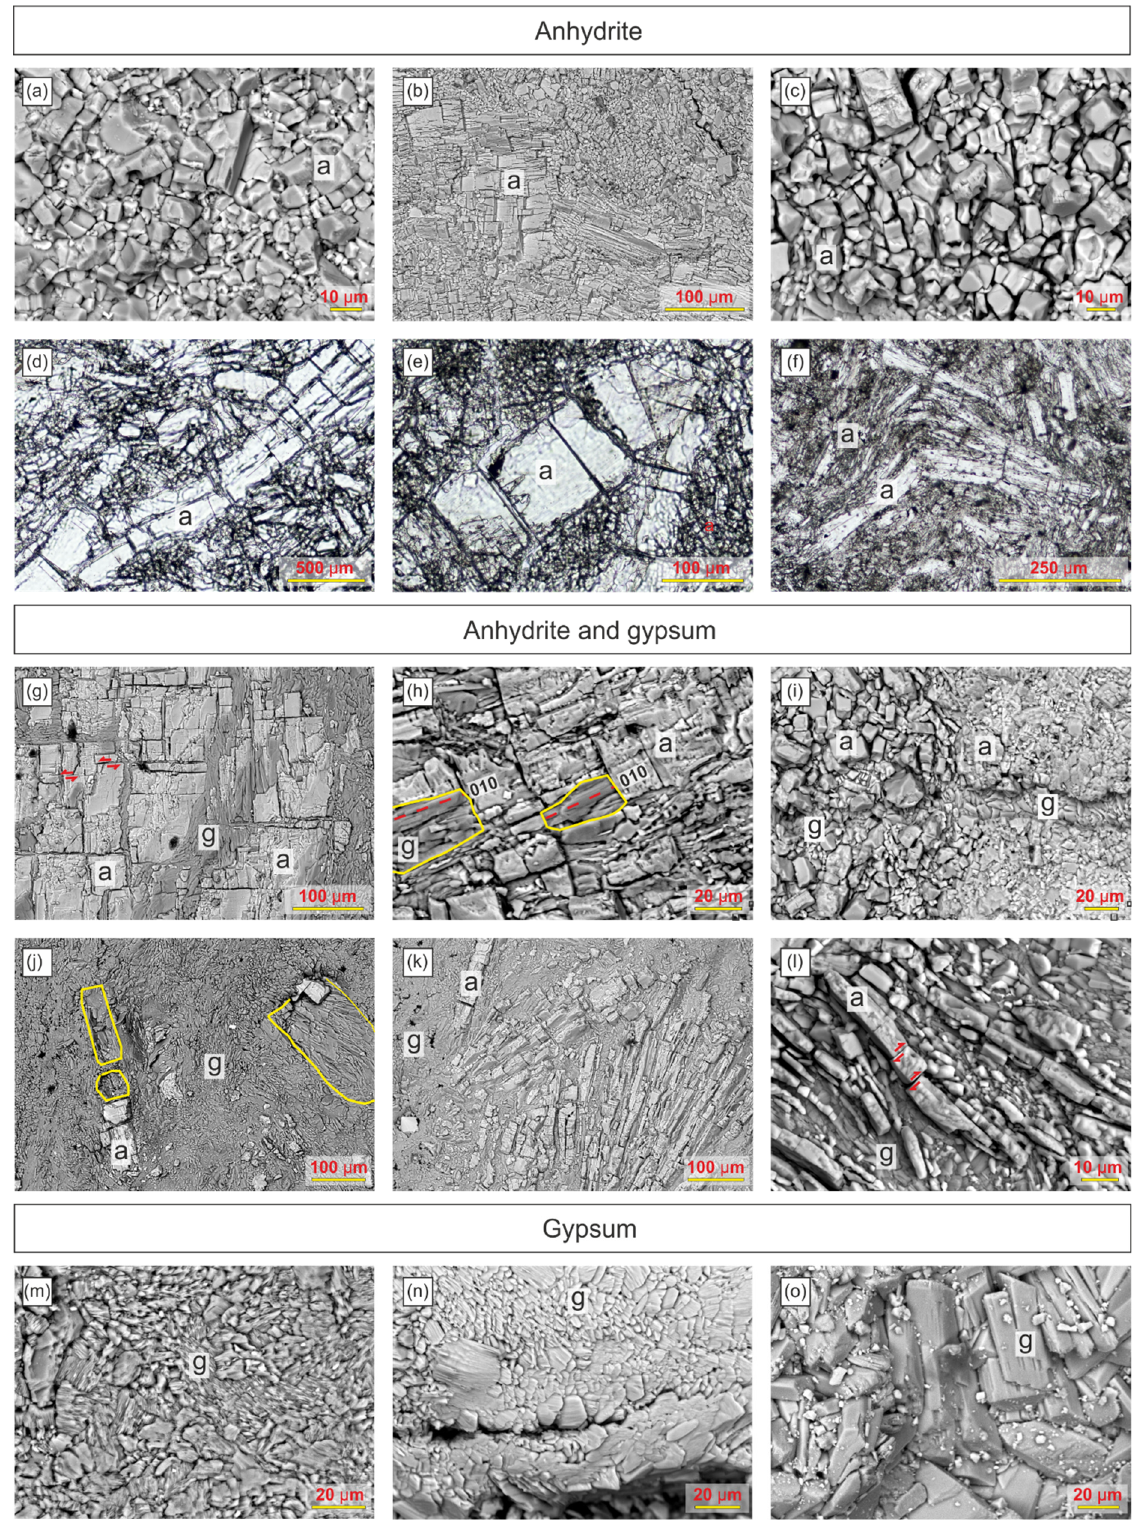
Figure 6. Fabric of the weathering anhydrites from Dingwall seen under optic ( d – f ) and scanning electron microscope (BSE images; a – c , g – o ) before transformation of anhydrite into gypsum ( a – f ), during gypsification ( g – l ) and after that process ( m – o ); a–anhydrite, g–gypsum; red dashed line– traces of the 010 perfect gypsum cleavage oriented parallel to cleavage of adjoining anhydrite grains suggesting epitaxial relationships between both minerals; yellow outline marks gypsum